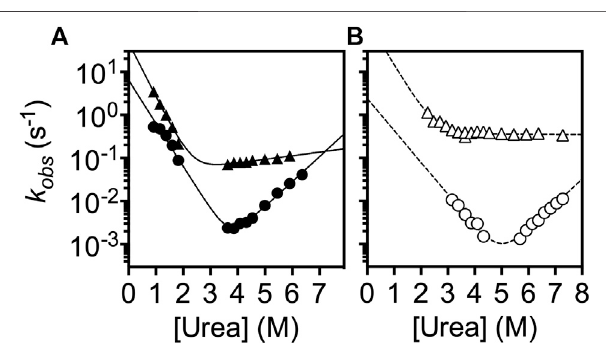
FIGURE 3 | Chevron plot analysis of the folding kinetics of l YibK and c YibK. The observed folding rates of l YibK (A) and c YibK (B) are plotted as a function of urea concentration. Two kinetic phases were observed. Circles and triangles correspond to the slow and fast kinetic phases, respectively. Filled and open symbols are used for l YibK and c YibK, respectively. The data were fi tted to a simple two-state folding model.